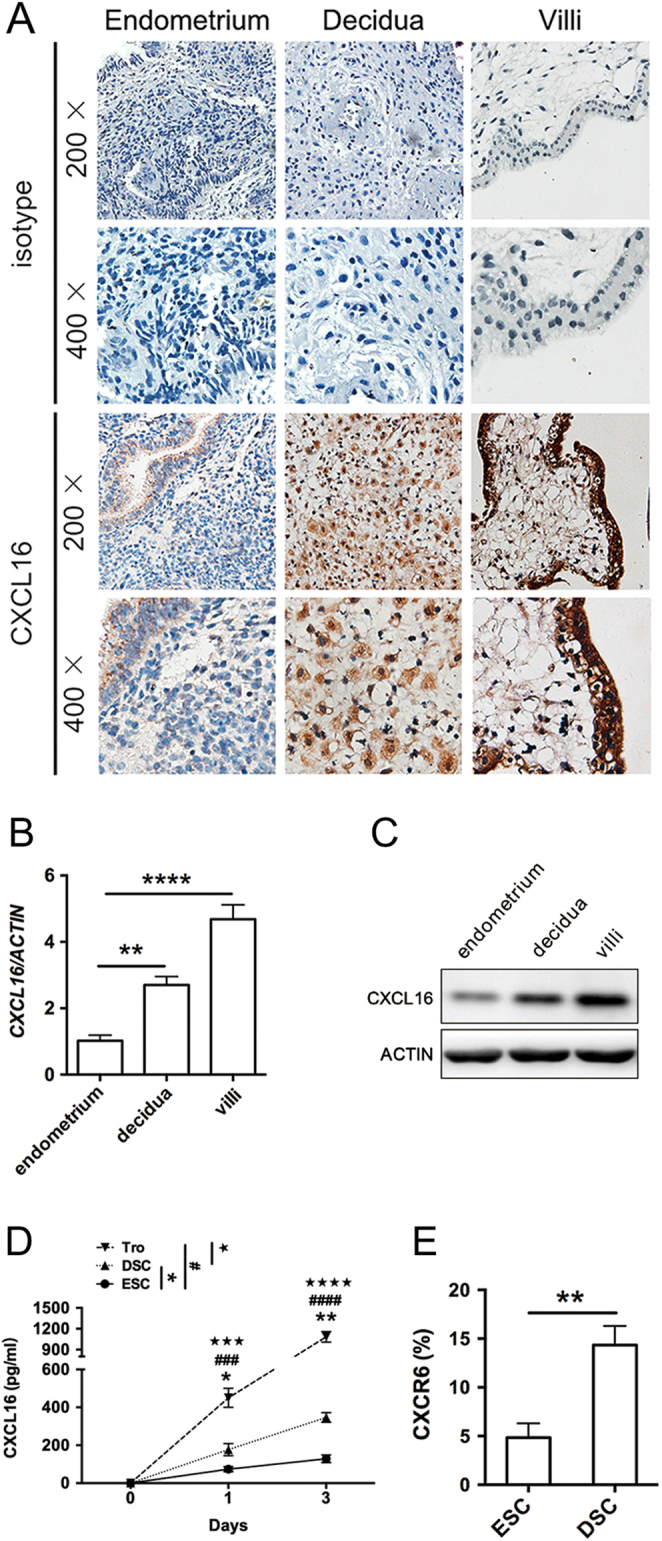
Expression of CXCL16/CXCR6 at the maternal–foetal interface during decidualization. (A) Representative micrographs for CXCL16 immunostaining in normal endometrium from a control group (ii), decidual tissues (iii), and villus (iv) from normal pregnancies. Negative antibody isotype staining of the normal tissue was represented as control (i). Magnification, ×200, ×400. (B and C) The CXCL16 transcript and translation levels in endometrium, decidual tissues and villus were quantified by real-time PCR and immunoblotting and were then normalised to actin expression. (D) To identify the secretory CXCL16 level of ESCs, DSCs and trophoblast cells, the culture supernatants (1 and 3 days) were collected for CXCL16 measurements by ELISA. (E) The expression of CXCR6 in DSCs and trophoblast cells was detected in 3 days by flow cytometry. Decidua, decidua from normal pregnancy; DSC, decidual stromal cell from normal pregnancy; endometrium, normal endometrium; ESC, endometrial stromal cell; Tro, trophoblast cells from normal pregnancy; villi, villus tissues from normal pregnancy. Representative data were shown as well as the mean ± s.d. (n = 12). Scale bar = 50 mm. **P < 0.01, ****P < 0.0001. In (C), DSC vs ESC, *P < 0.05, **P < 0.01; Tro vs ESC, ###P < 0.001, ####P < 0.0001; Tro vs DSC, ★★★P < 0.001, ★★★★P < 0.0001.